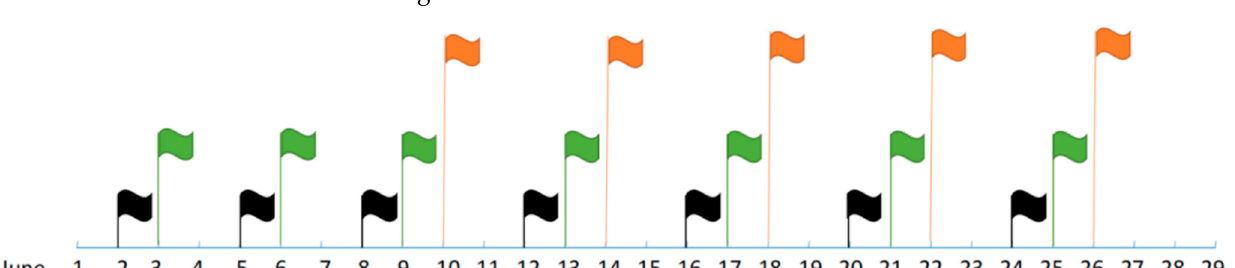
Figure 1. Illustration of the experiment’s method. The black flag indicates the day that the samples were treated with melatonin (the illustration can be used for all melatonin gradients); the green flag indicates the day that the samples were treated by NaCl and Na 2 CO 3 ; the red flag indicates the day that the samples are collected.